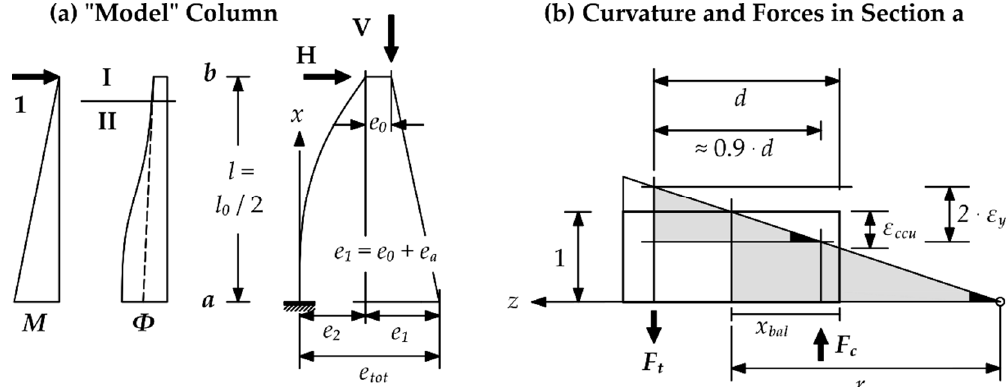
Figure 6. Effect of ε ccu on the column behavior under combined axial compression and bending [36]. ( a ) Model representation of a column exposed to normal force and bending moment. ( b ) Curvature and forces in Section a.